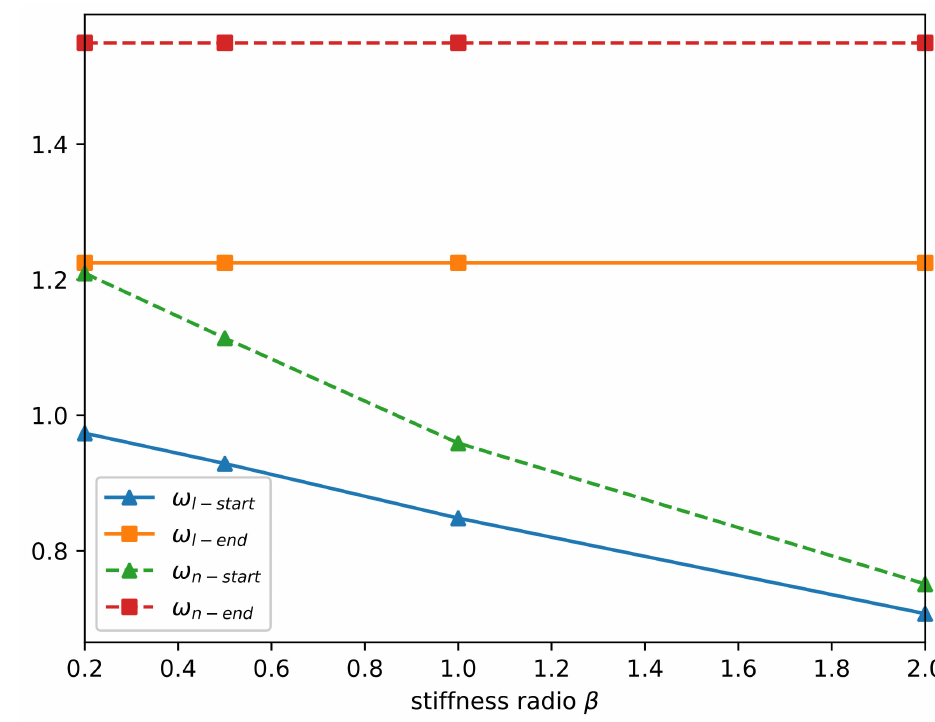
Figure 9. Effect of stiffness ratio on starting and ending frequencies.